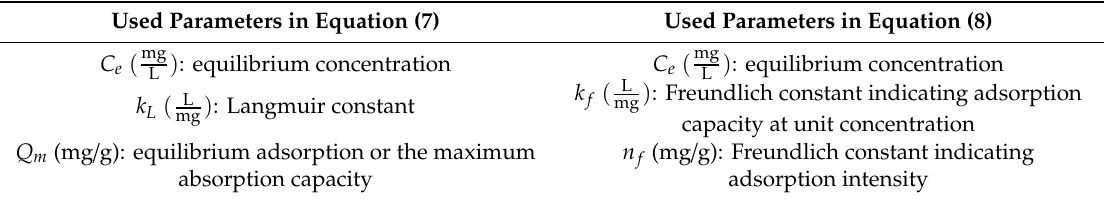
Table 4. Parameters used in Equation (7) to (8).